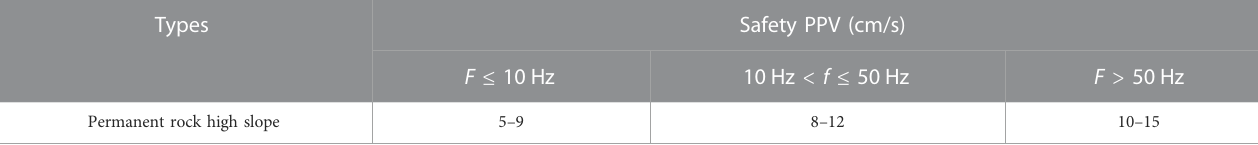
TABLE 3 Safety criterion of blasting vibration for rock slope in regulations [1]